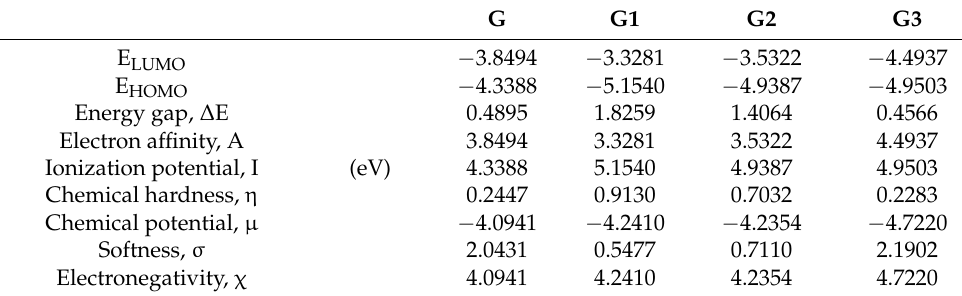
Table 1. The predicted electronic properties of the GON